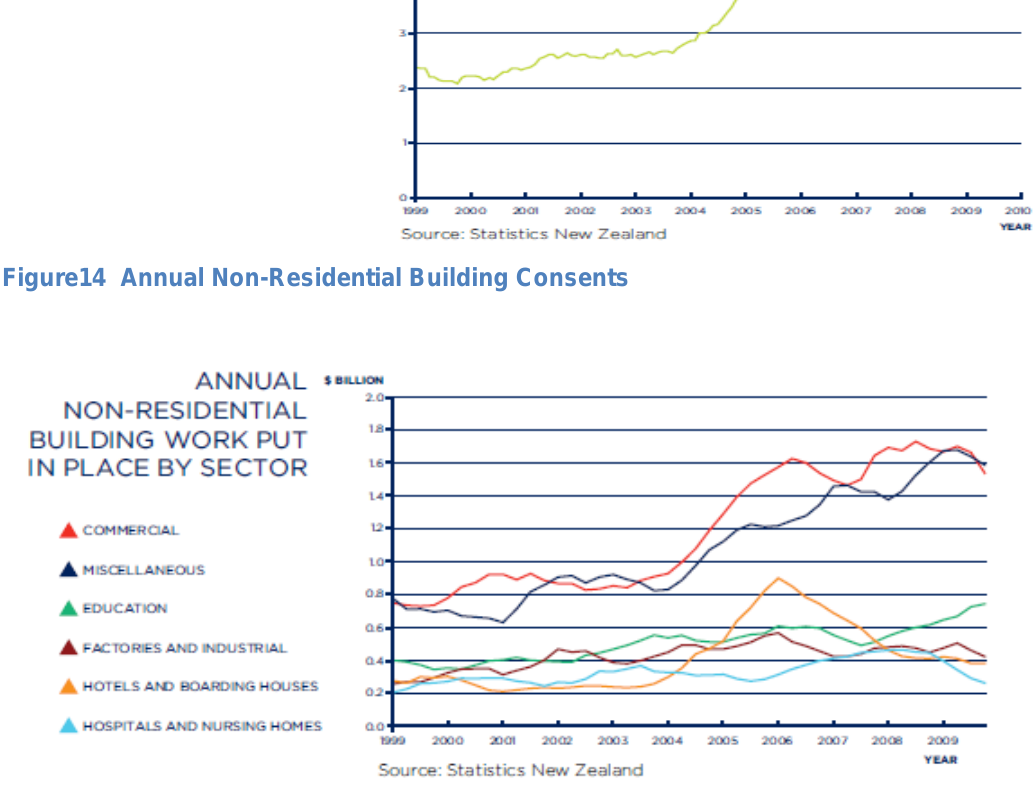
Figure 15: Annual Non-Residential Building Work Put in Place by Sector